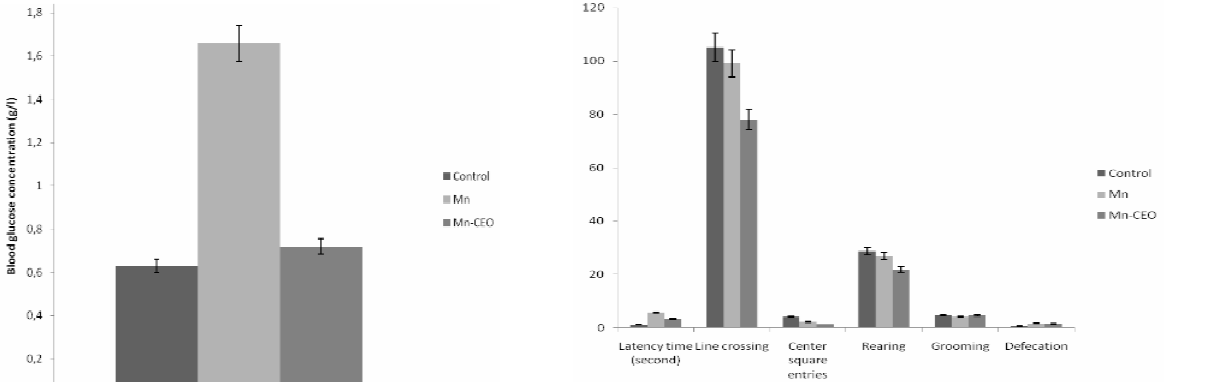
Fig. 4....Effect of the exposure to Mn and clove essential oil treatment during pregnancy and lactation on Locomotor activity. Data are mean±S.E.M. *** p <0.001, ** p <0.01, * p <0.05 (Mn vs. Control) p <0.01, p <0.05 (Mn vs. Mn-CEO) p <0.001, Mn-CEO – Mn-treated rats by clove essential